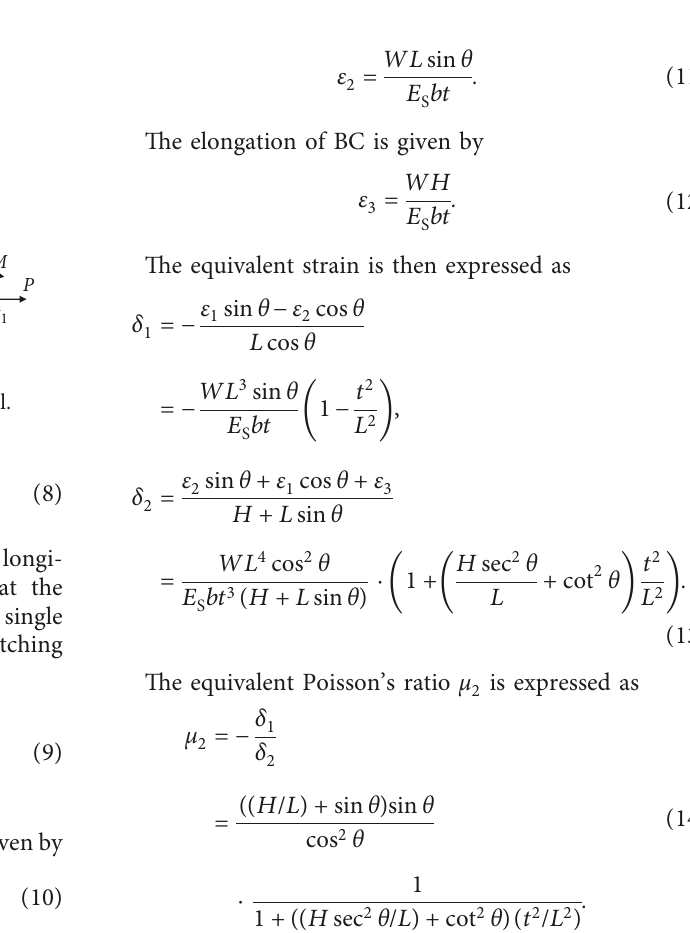
Figure 7: Longitudinal deformation of honeycomb